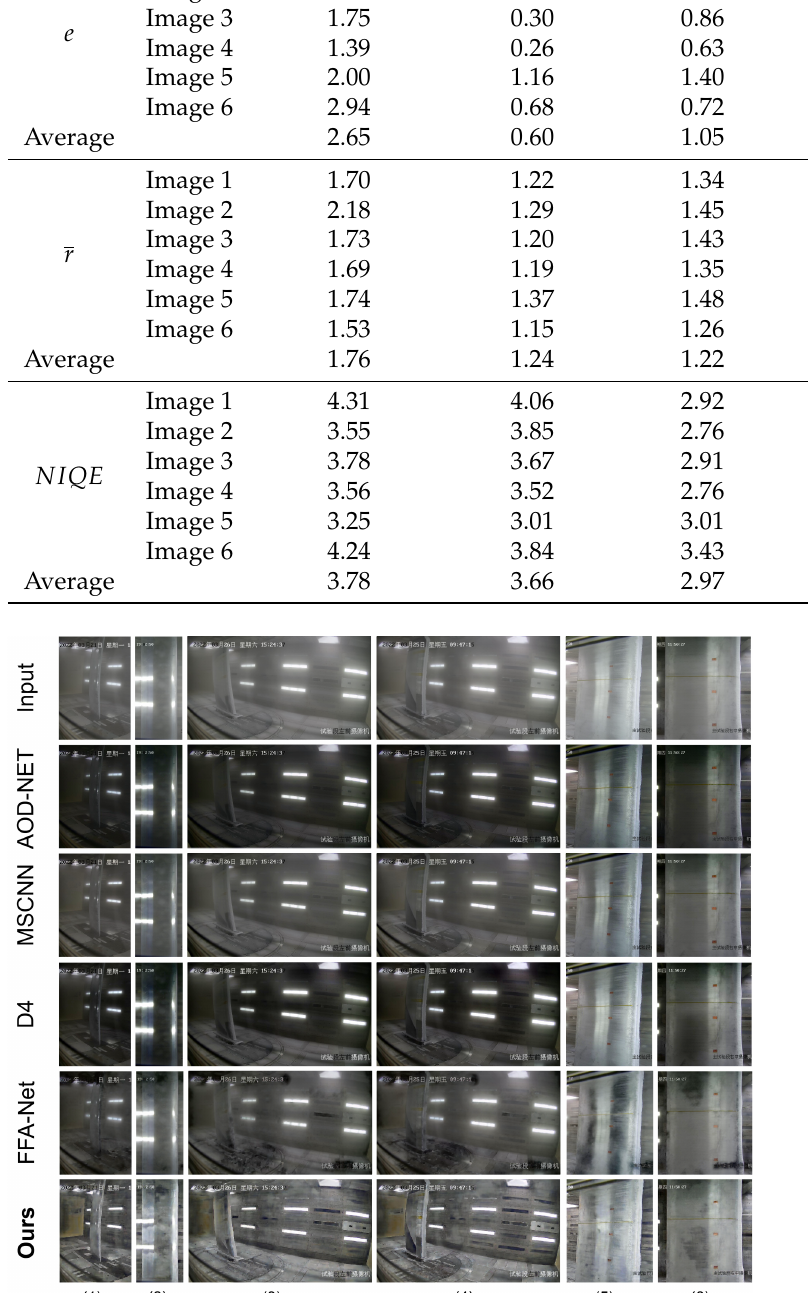
Figure 7. Comparison of six real foggy images in an icing wind tunnel with existing deep learning methods. ( 1 , 2 ) LWC = 1.31; ( 3 , 4 ) LWC = 1.0; ( 5 , 6 ) LWC =